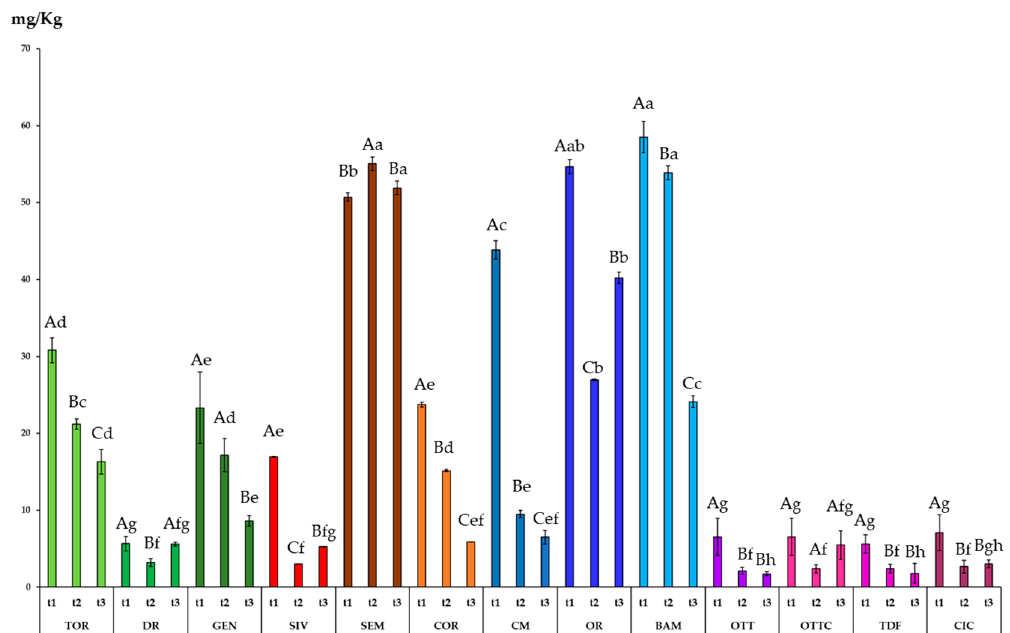
Figure 3. Chlorophyll content of 13 olive oils from minor Italian cultivars harvested at three different maturation stages. Data are expressed as the mean of three replicates ± standard deviations. Different capital letters, between the three harvesting times for the same cultivar, indicate significant differences ( p < 0.05). Different small letters, at the same harvesting time for the different cultivars, indicate significant differences ( p < 0.05).